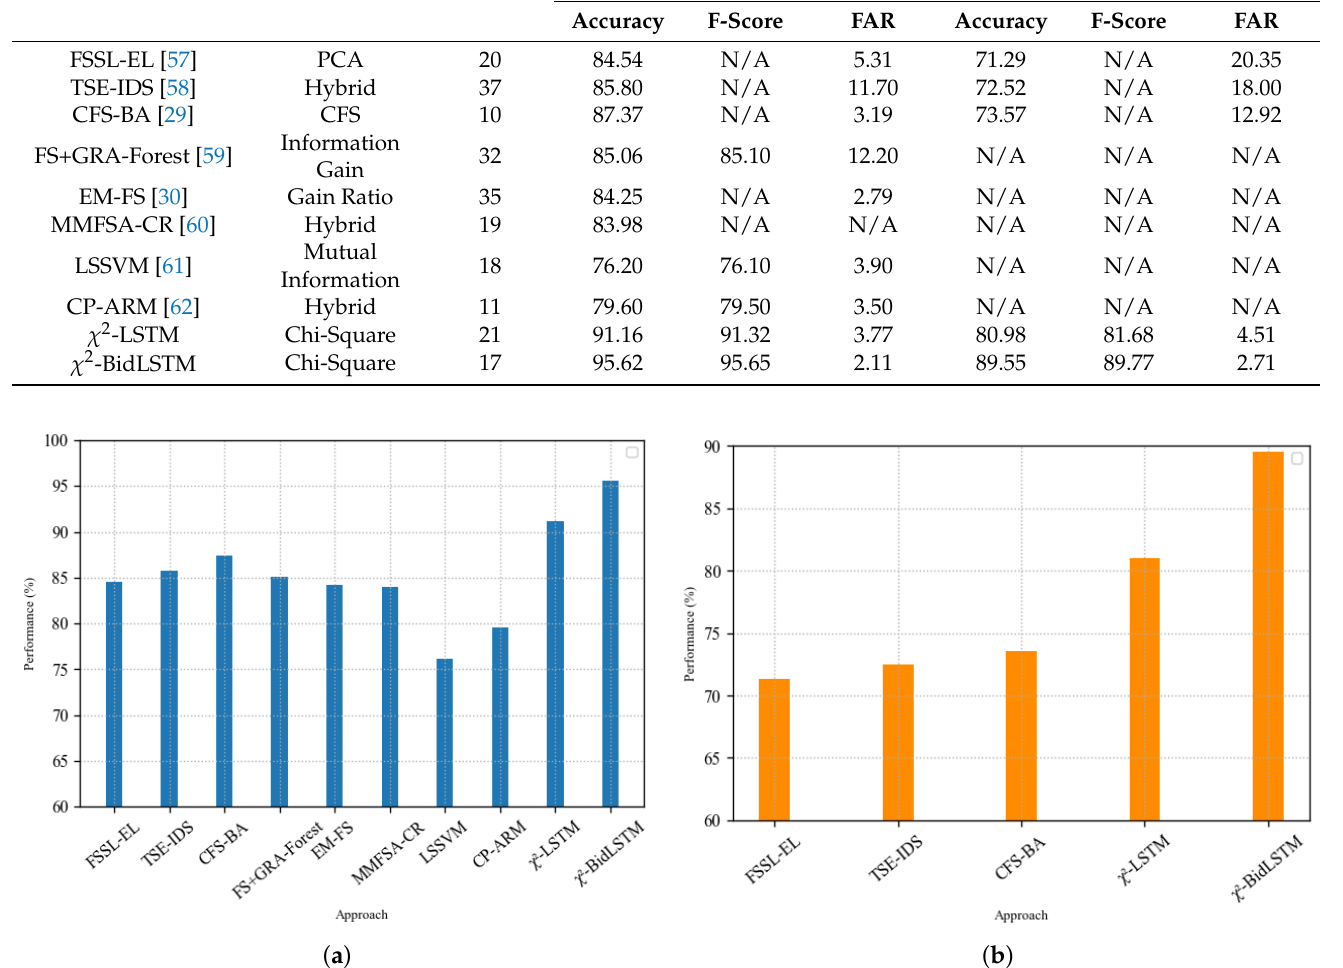
Figure 7. Comparison of results against existing feature selection methods on NSL-KDDTest + and NSL- KDDTest − 21 . ( a ) Performance results on NSL-KDDTest + ; ( b ) performance results on NSL-KDDTest − 21